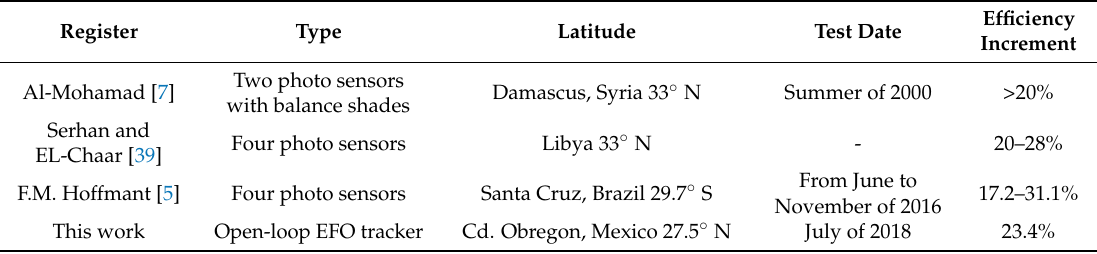
Table 6. Efficiencies of related